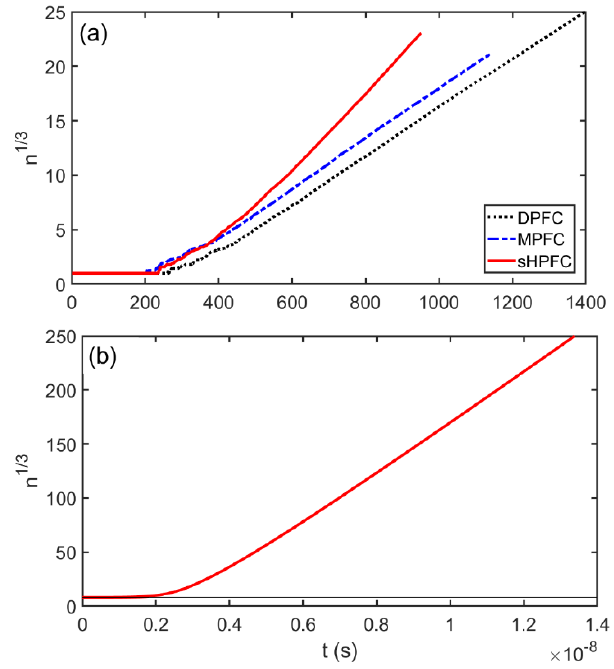
Figure 9. Post-nucleation growth: ( a ) effective linear size vs. time for the clusters shown in Figures 5–7; ( b ) effective linear size vs. time for an iron cluster nucleated at 1500 K as follows from integrating Equation (1). Note the similarity of the curves presented in panels ( a , b ).